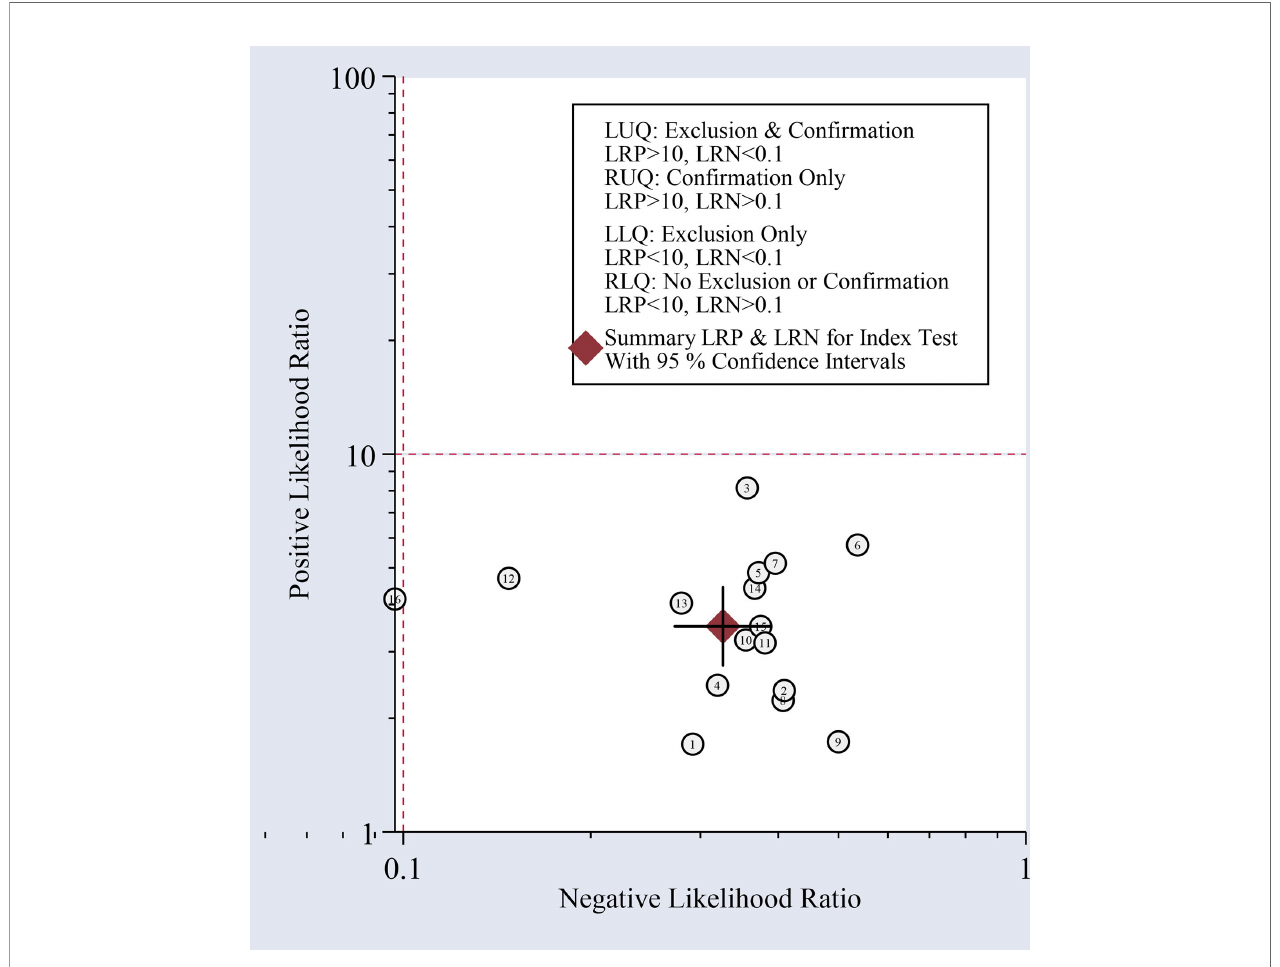
FIGURE 5 | Scatter plot of positive and negative likelihood ratios with combined summary points.